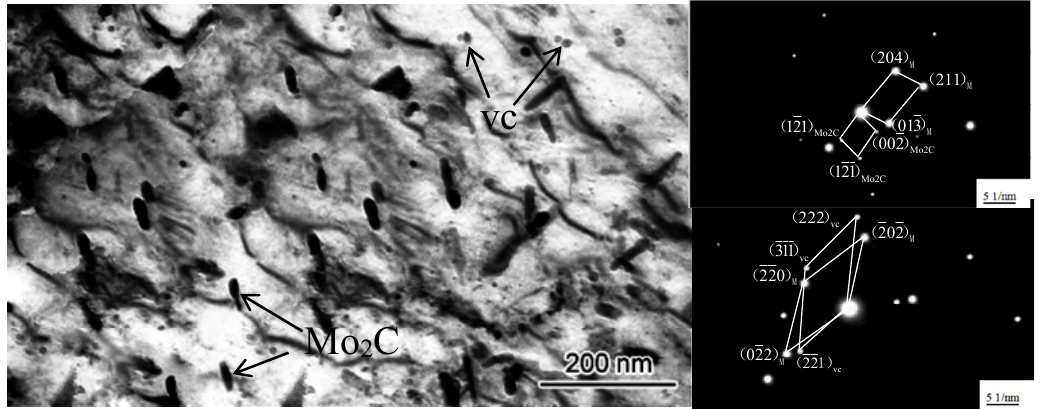
Figure 10. TEM image of plasma cladding coating and selective diffraction.